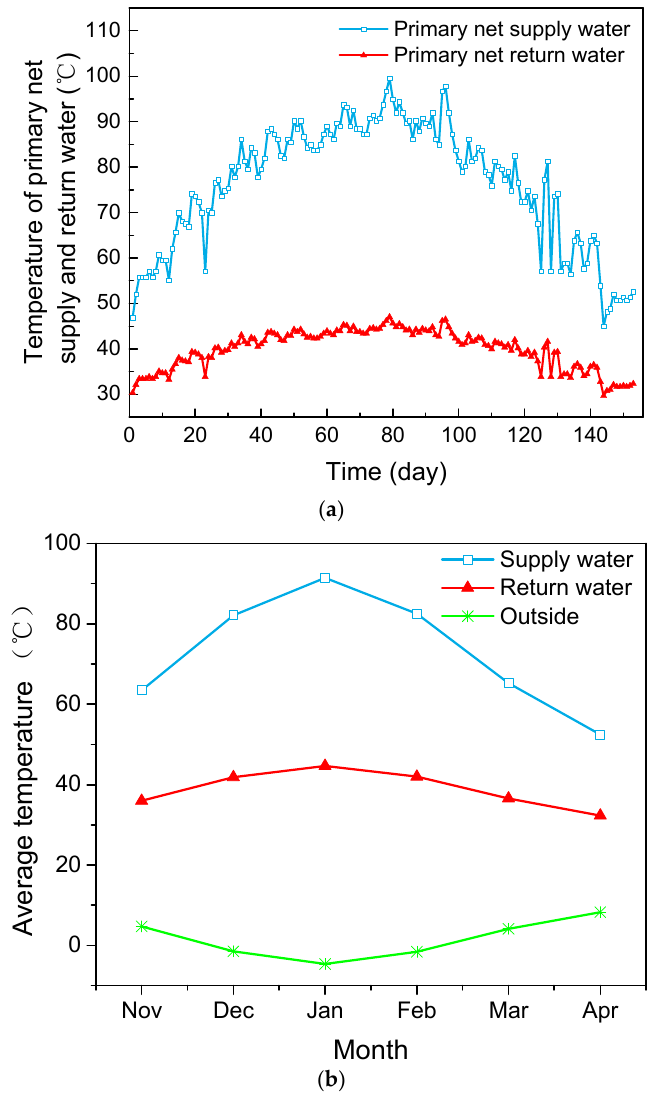
Figure 5. Temperature curve of the primary network supply and return water in the demonstration power plant. ( a ) Daily temperature; ( b ) Month average temperature.